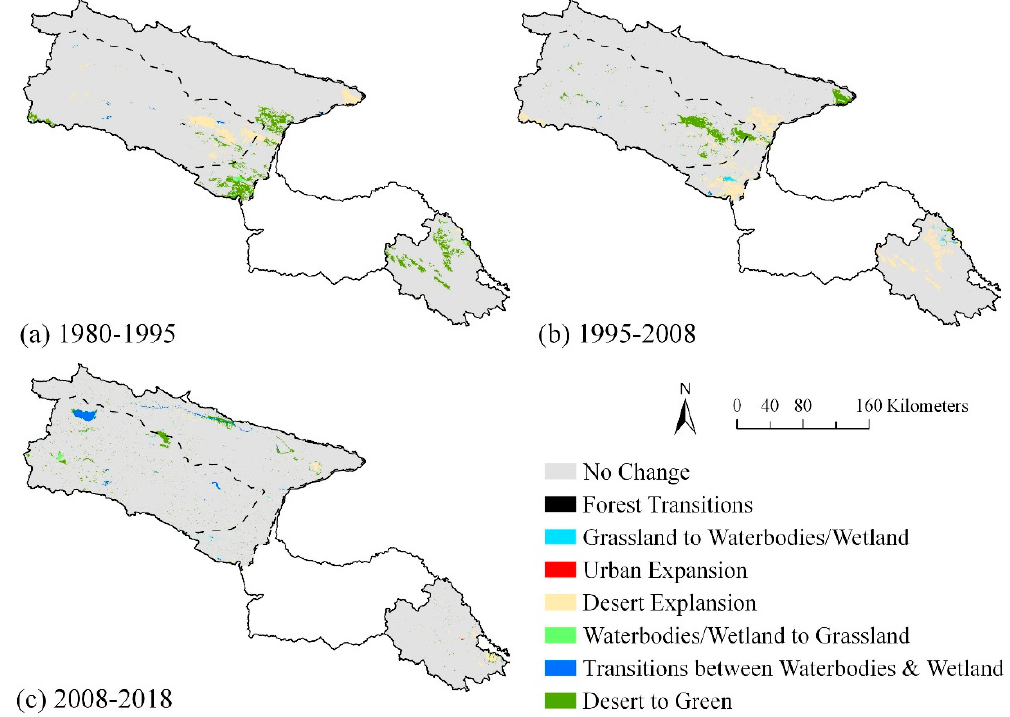
Figure 3. Comparison of land use/land cover change in HXNR and the control area for ( a ) 1980–1995, ( b ) 1995–2008, and ( c ) 2008–2018. Table 4. Land use/land cover conversions in the study area for different periods before and after the establishment of the